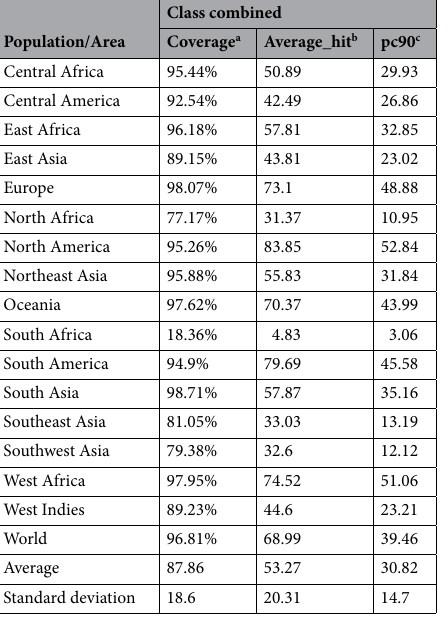
Table 5. Population coverage of ZIKVac. The coverage estimation was made using Population Coverage tool available on IEDB online. a Projected population coverage. b Average number of epitope hits / HLA combinations recognized by the population. c Minimum number of epitope hits / HLA combinations recognized by 90% of the population.